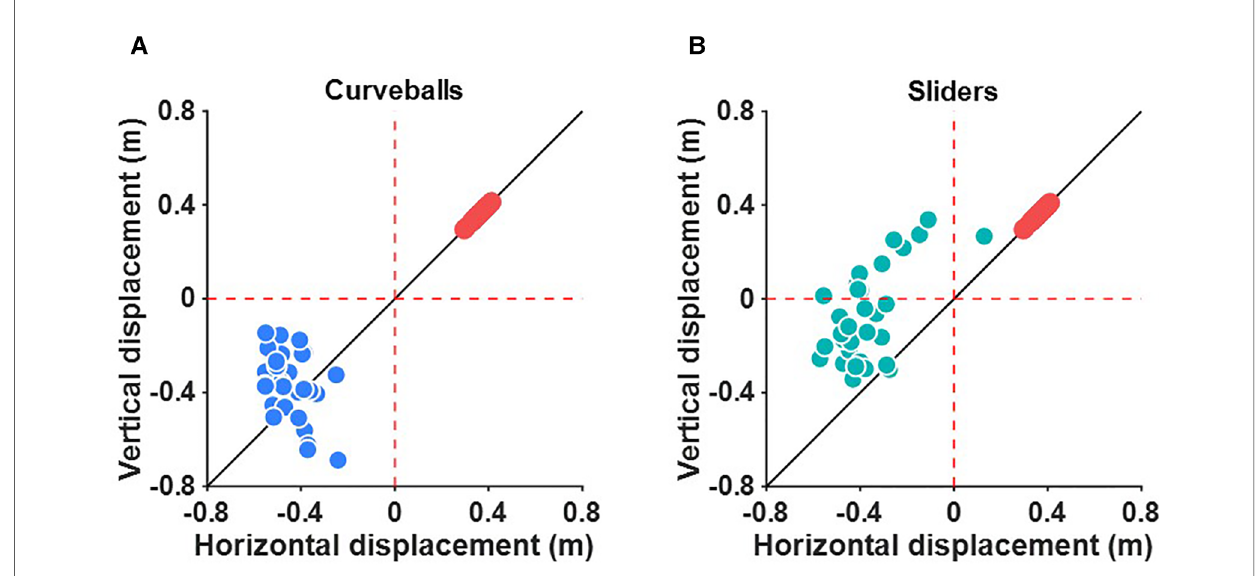
FIGURE 5 The relative deviation of ( A ) the curveballs and ( B ) the sliders from the four-seam fastballs. The black line indicates that the amount of deviation of the vertical and left-right directions are equal. Red, blue, and green dots indicate the deviation of the four-seam fastballs, the curveballs, and the sliders after